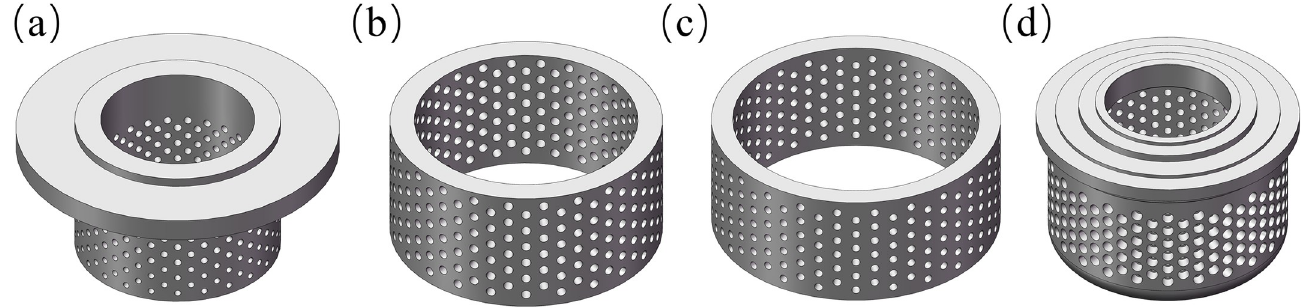
Fig 2. The pressure reducing components. (a) Inner sleeve. (b) Middle sleeve. (c) Outer sleeve. (d) Valve seat with noise reduction cage.